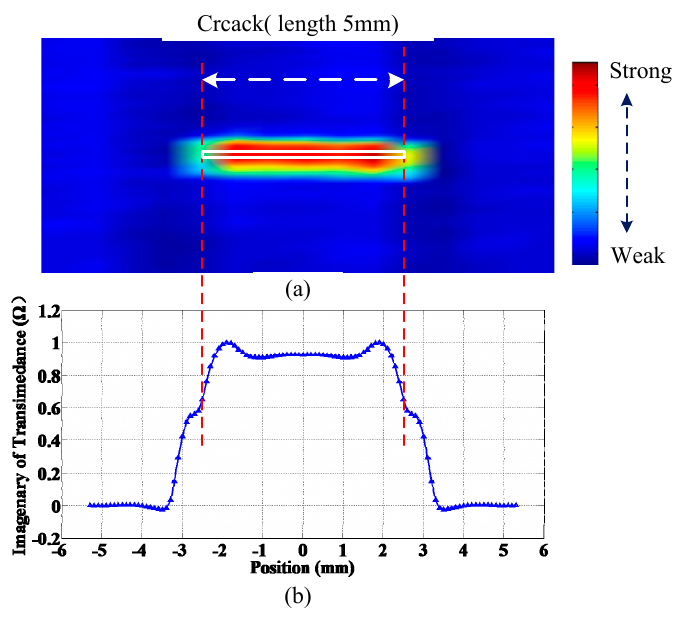
Figure 6. ( a ) C-scan image of a 5 × 0.2 × 0.5 mm defect; ( b ) Simulated peak output curve along length direction.